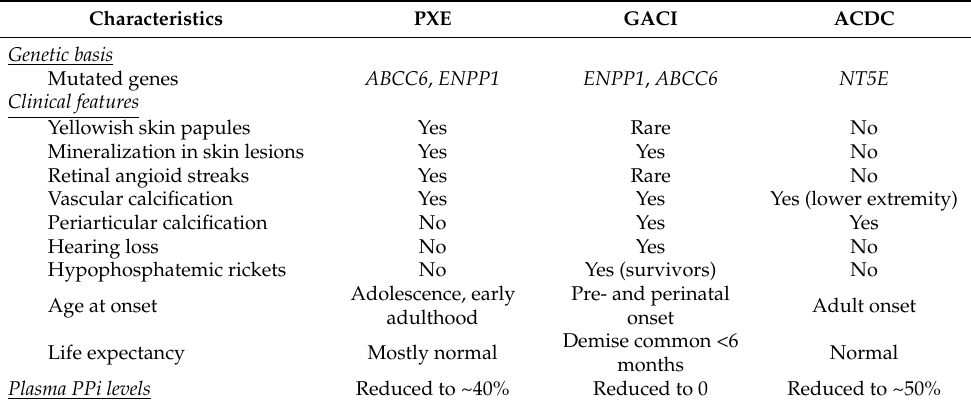
Table 1. Clinical and genetic features of PXE, GACI, and